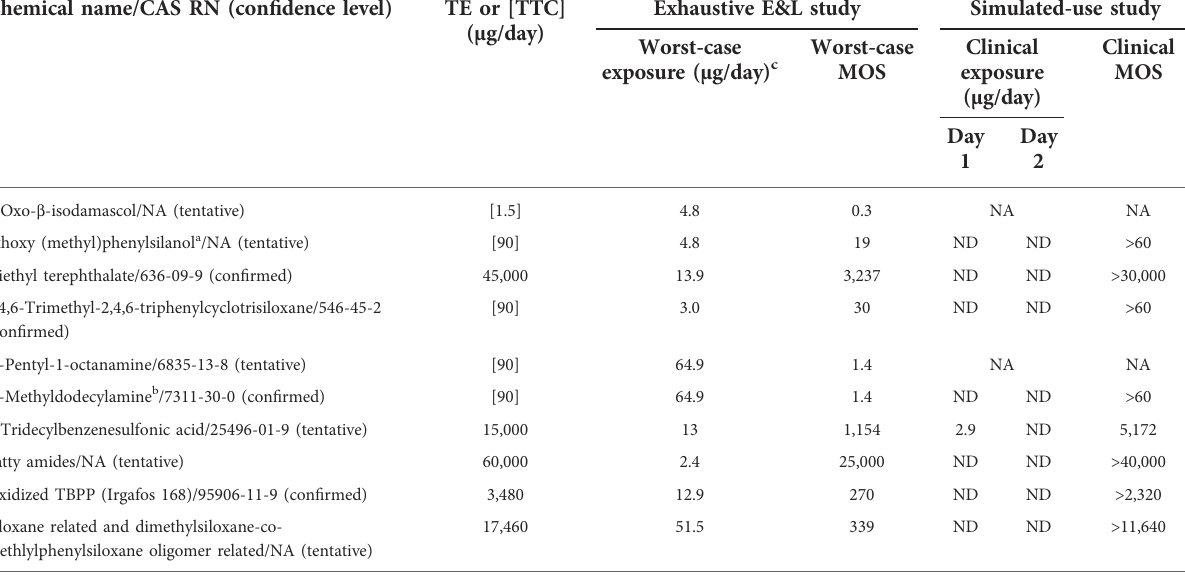
TABLE 1 Risk characterization of extractables and leachables from devices processed using the new detergent formulation. Chemical name/CAS RN (con fi dence